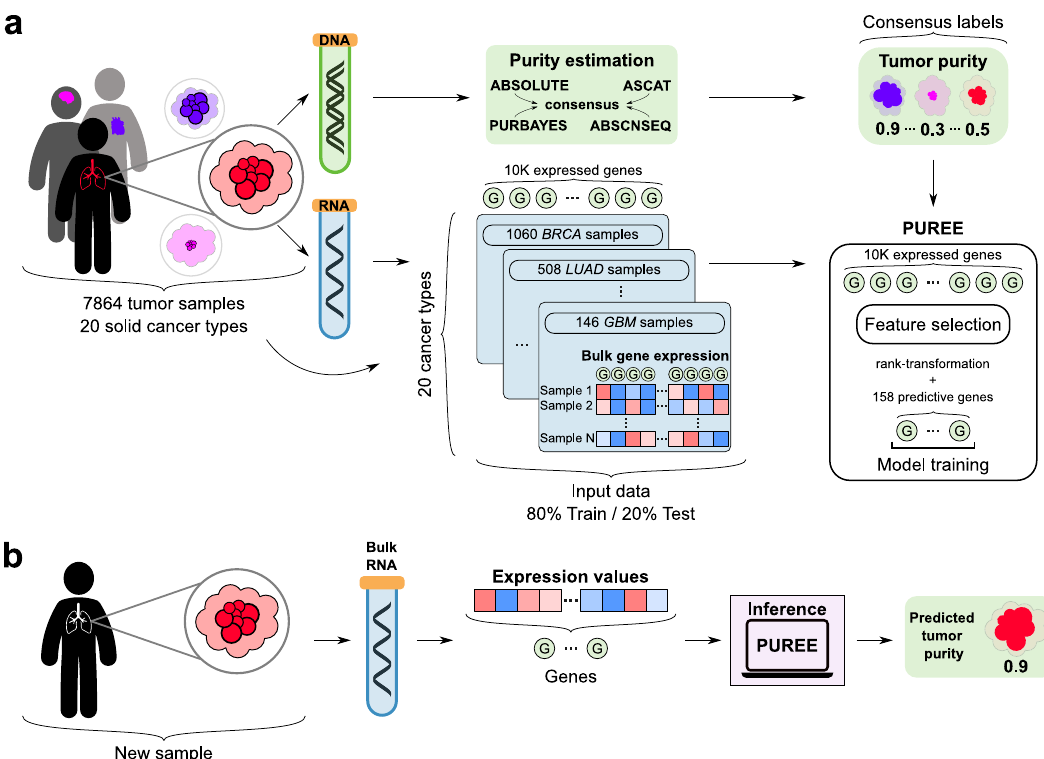
Fig. 1 Overview of PUREE. a PUREE is trained using a weakly supervised learning approach. Consensus genomics-based purity estimates are used as orthogonal (pseudo-ground-truth) labels, and a predictive model is trained on rank-transformed gene expression pro fi les from 7864 tumor samples spanning 20 solid tumor types (80%/20% train/test split). b For a new solid tumor sample, PUREE infers the purity from the corresponding tumor gene expression pro fi